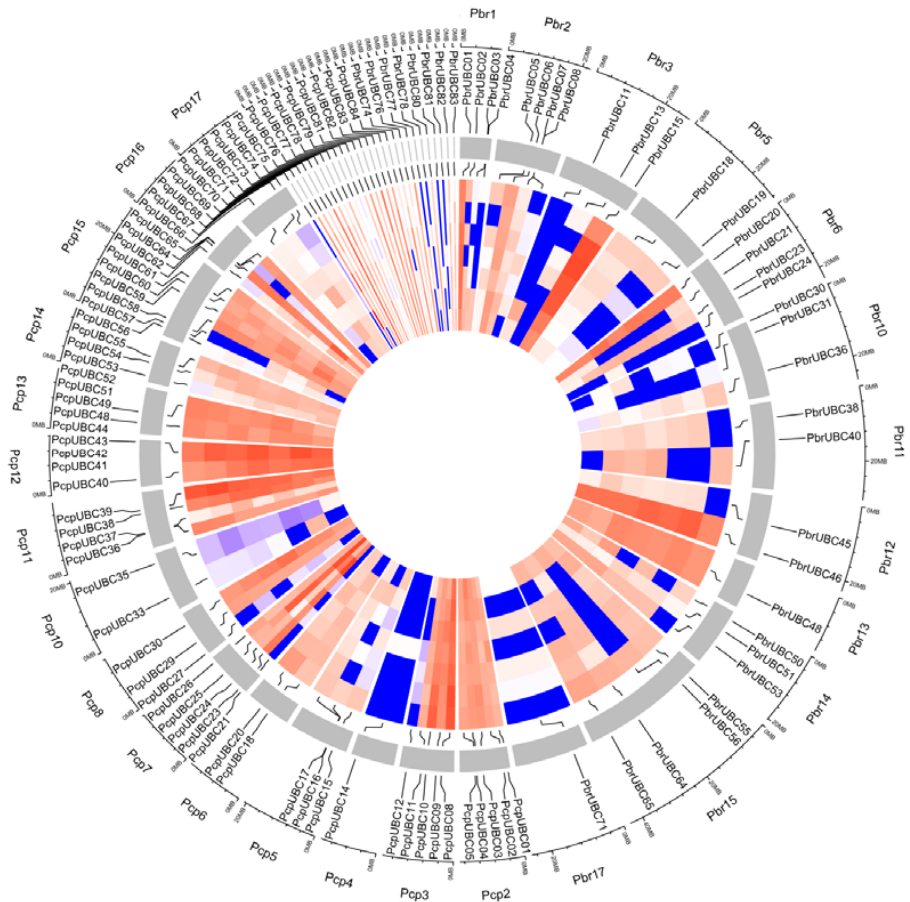
Figure 5. Expression of UBC genes from P. bretschneideri and P. communis during fruit development and ripening, including Fruit_stage1 (15 days after full blooming (DAB)), Fruit_stage2 (30 DAB), Fruit_stage3 (55 DAB), Fruit_stage4 (85 DAB), Fruit_stage5 (115 DAB), Fruit_stage6 (mature stage), and Fruit_stage7 (fruit senescence stage). The color scale represents normalized log 2-transformed, where grey indicates a medium level, blue indicates a low level, and red indicates a high level. Circos software was used to visualize the heat map. The FPKM values of PbrUBCs and PcpUBCs are presented in Table S3. The outermost ring represents Fruit_stage7, followed by Fruit_stage6, Fruit_stage5, Fruit_stage4, Fruit_stage3, and Fruit_stage2, and the innermost ring represents Fruit_stage1.